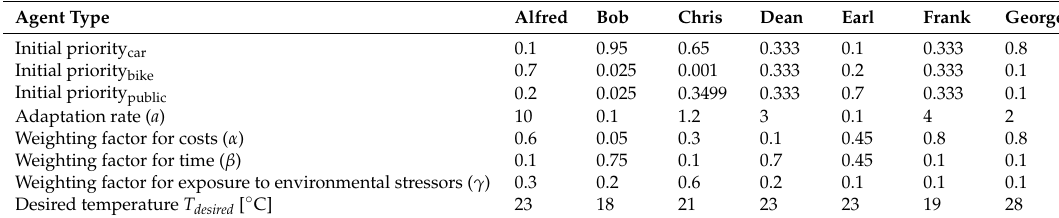
Table 4. Attribute rs of different agents.